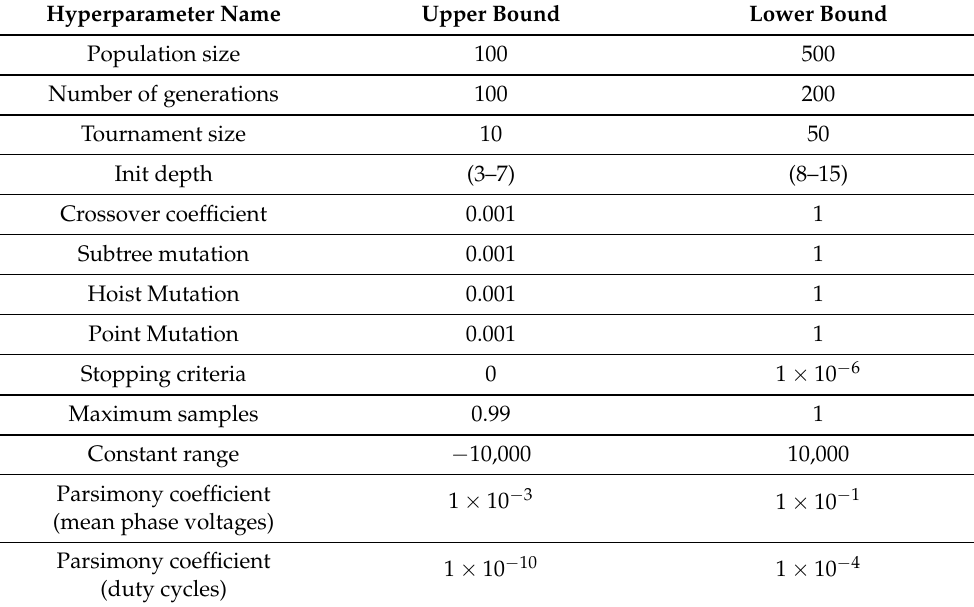
Table 3. The range of GPSR hyperparameters used in this